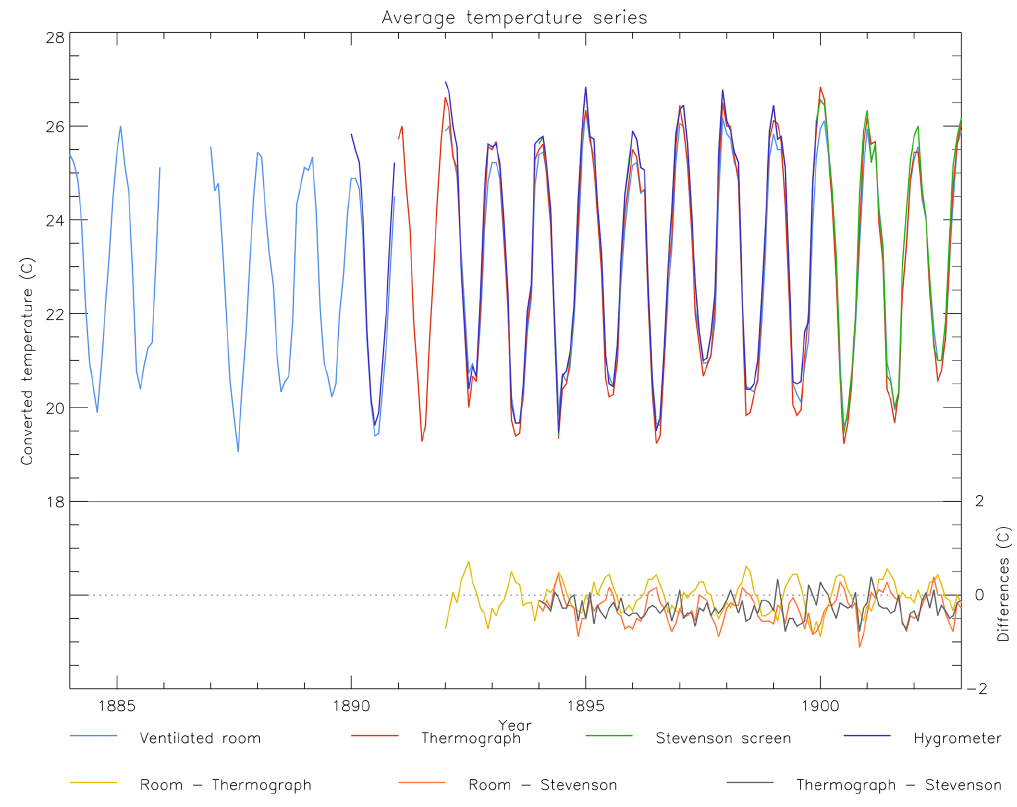
Figure 15. As Fig. 11, but for monthly average temperatures (Ta) that extend for longer and are more contiguously available from all four techniques (including the hygrometer). For all techniques except the thermograph, Ta is calculated from the mean of observations at 06:00 and 15:00LST. For the thermograph it is the mean of the 24-hourly observations. The hygrometer series is relatively short, and it is shown only in the top panel. Significance of differences is assessed in Table 2 for this